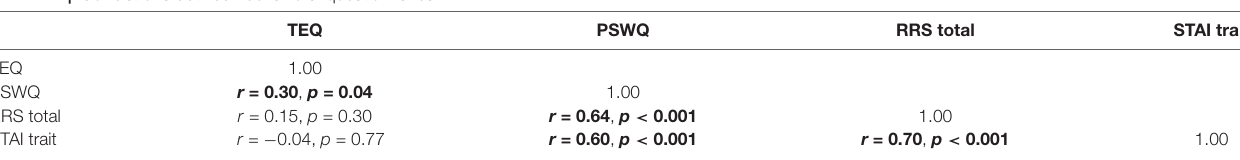
TABLE 2 | Correlations between behavioral